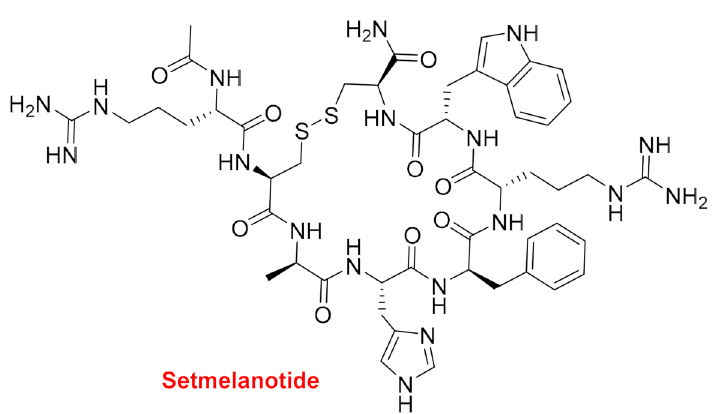
Figure 4. Structure of setmelanotide.